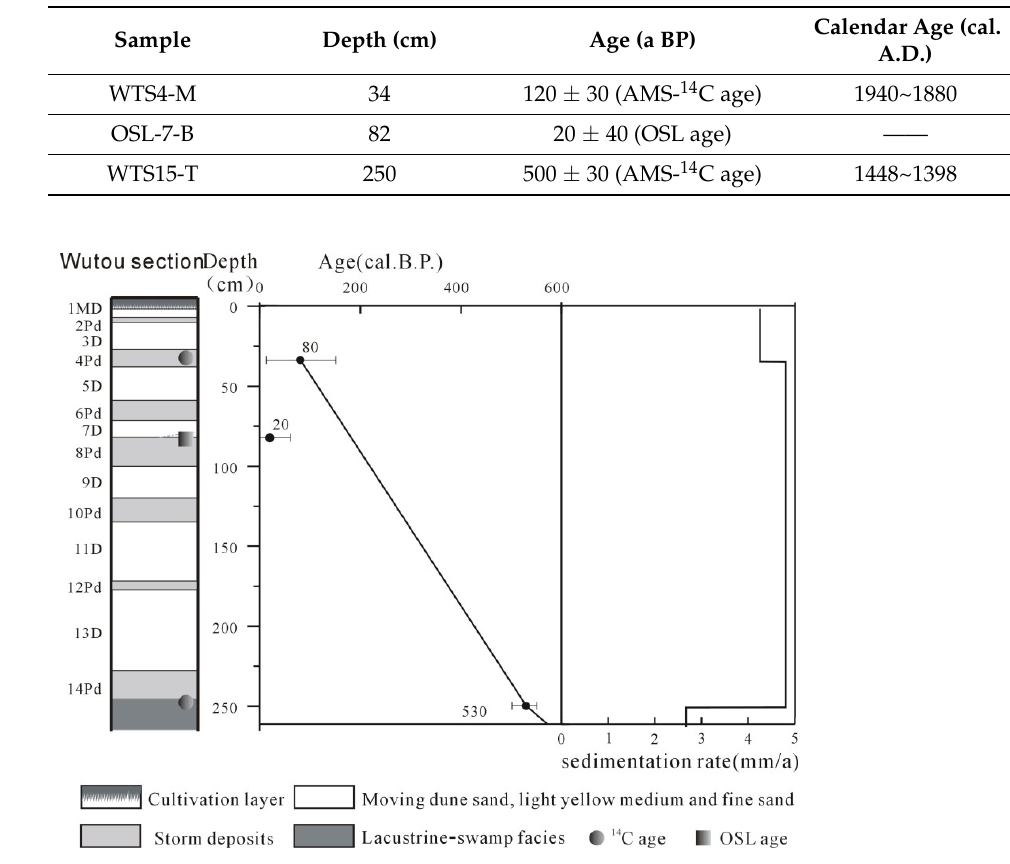
Figure 2. Age and sedimentation rate of the Wutou